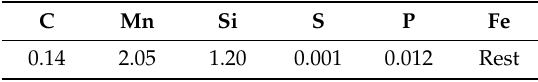
Table 1. Chemical composition of the steel (in mass %).